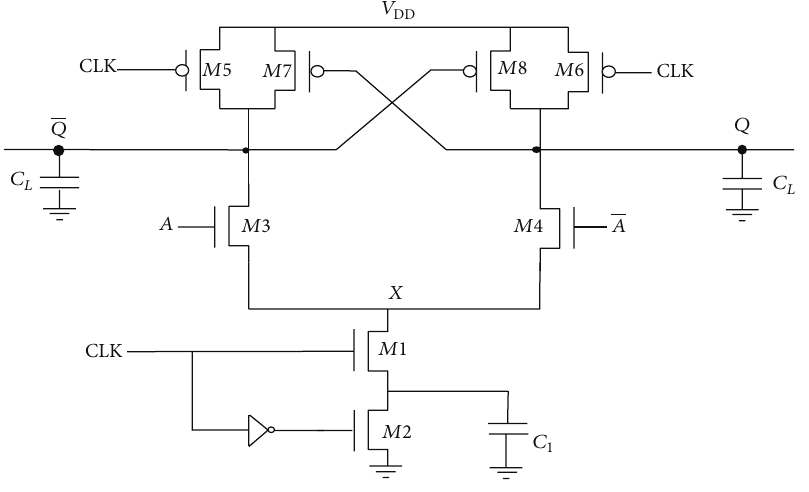
Figure 1: DyCML inverter [15,